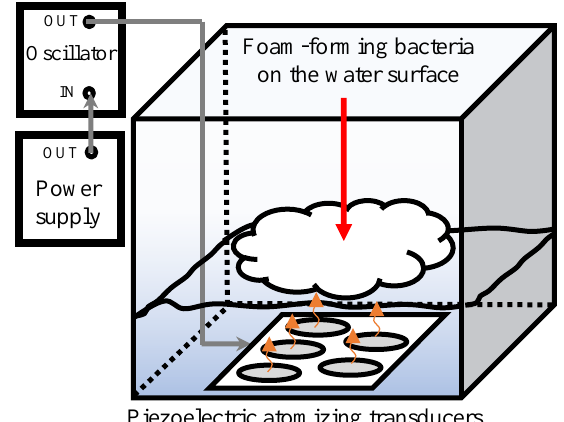
Fig. 1. The experimental setup